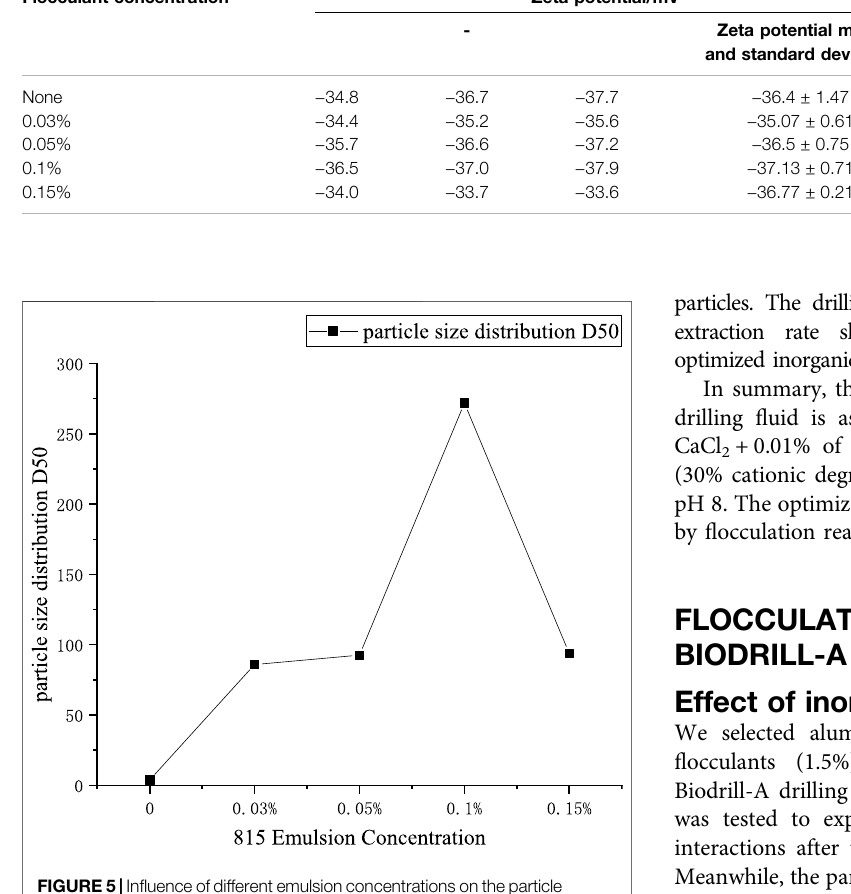
TABLE 5 | In fl uence of different emulsion concentration on the zeta potential and particle size distribution in Biodrill-A drilling fl uid. Flocculant concentration